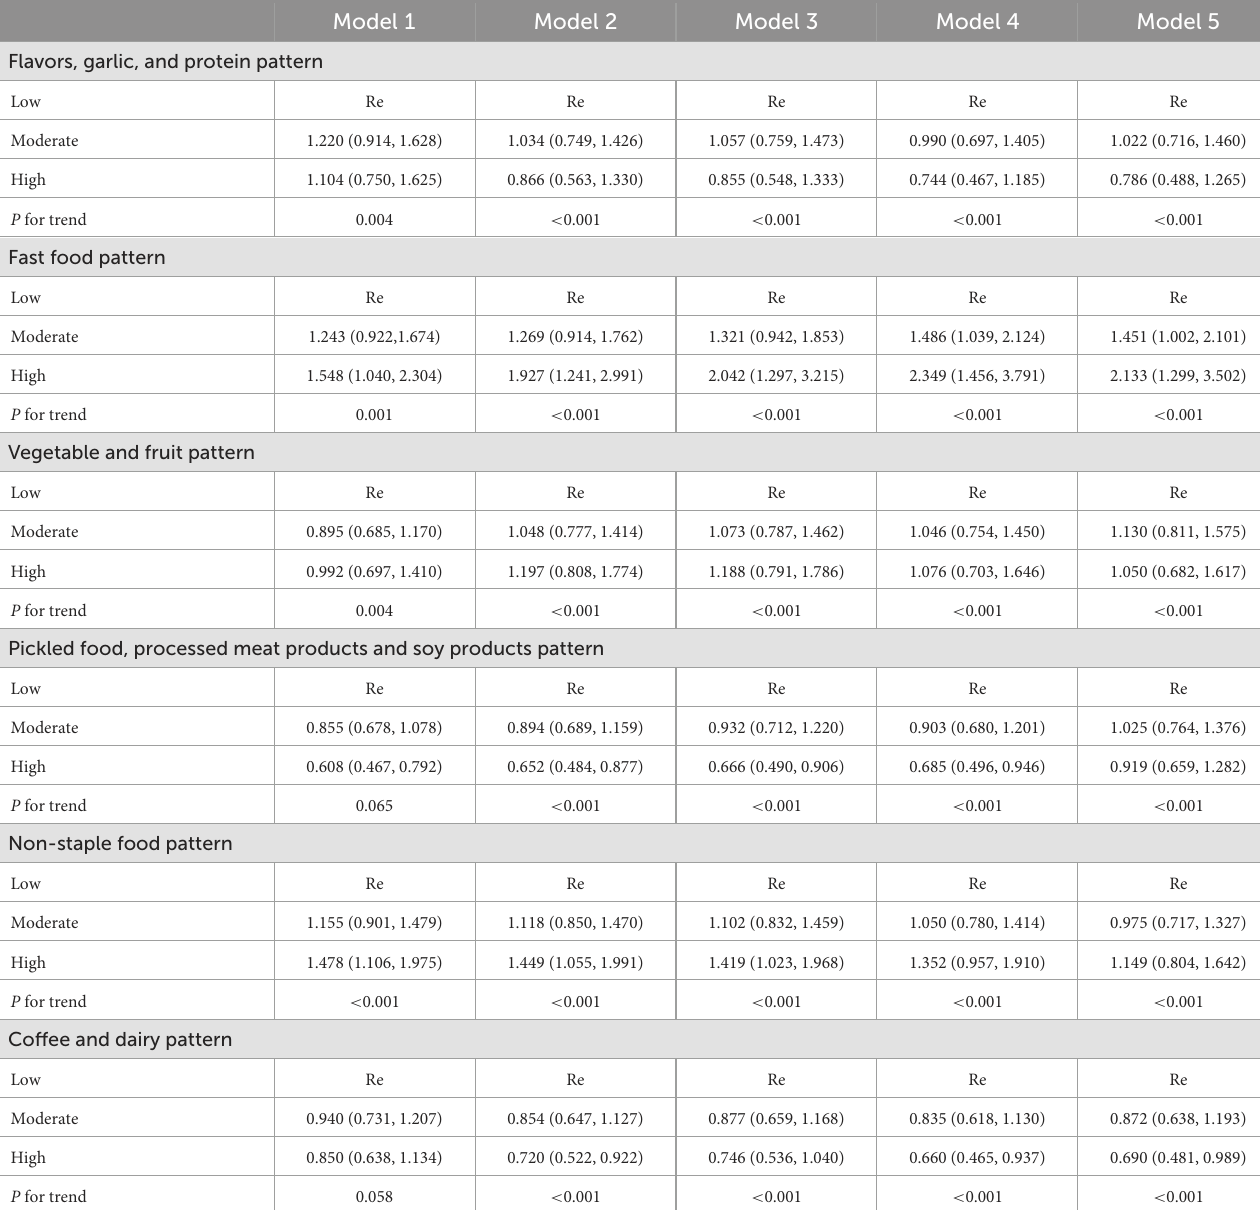
TABLE 3 Association between dietary patterns and risk for gastric